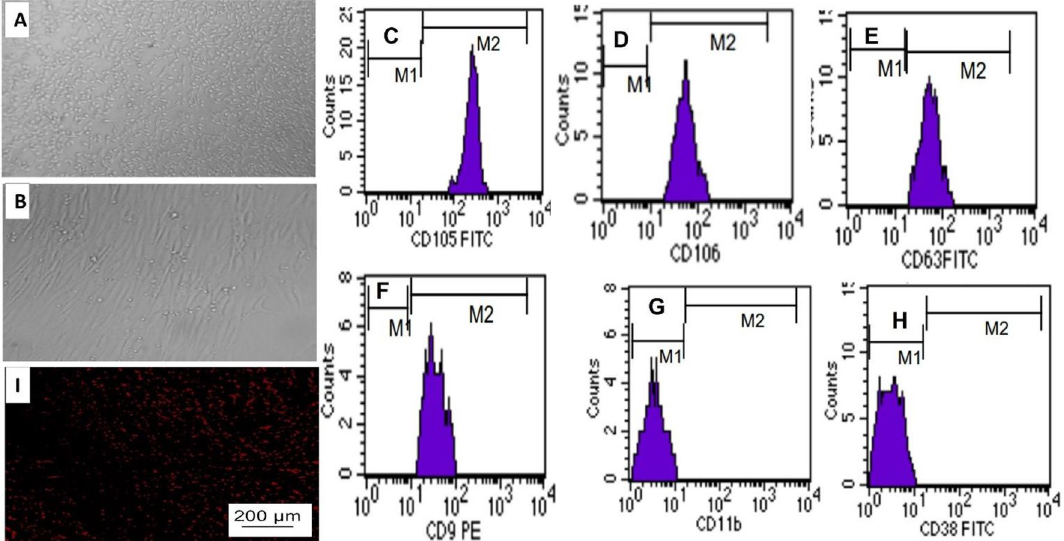
Figure 1. The adhesiveness and fusiform shape of MSc at day 14 were presented ( A , B ). Flowcytometry charts (M1; negative, M2; positive) showed MSc express CD105 ( C ), CD106 ( D ), CD63 ( E ) and CD9 ( F ) on cell surface however they do not express CD11 ( G ), or CD38 ( H ). ( I ) Representative fluorescence micrographs of cerebral cortex from toluene and breast milk-MSc-treated group following MSc dosing displaying the homing of MSc by PKH26